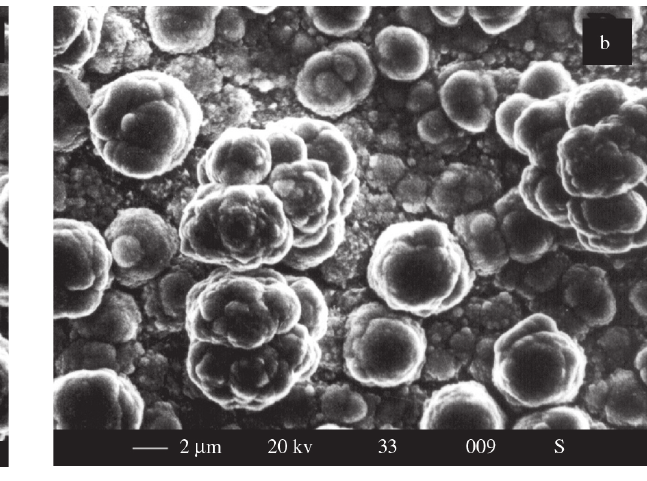
Figure 1. Morphology of coatings from Bath 1: a) 116 A/m 2 ; b) 154 A/m 2 .